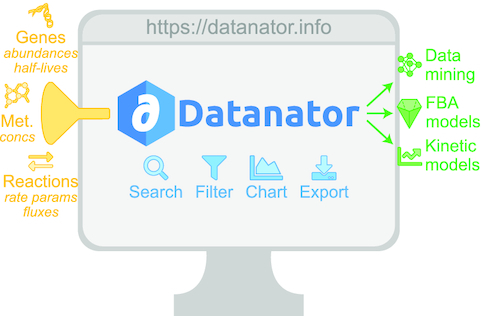
Datanator (https://datanator.info) is an integrated database of molecular data. To help investigators find relevant data for research even in the absence of direct measurements, Datanator includes tools for assembling "clouds" of measurements centered on a specific molecule or reaction in a particular organism that encompass measurements of similar molecules and reactions in similar organisms. Datanator is ideal for integrative and comparative analysis and modeling.